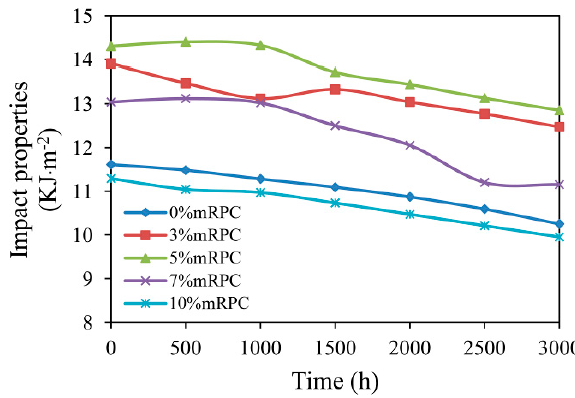
Figure 10. Effect of mRPC mass percentage and aging time on impact strength.